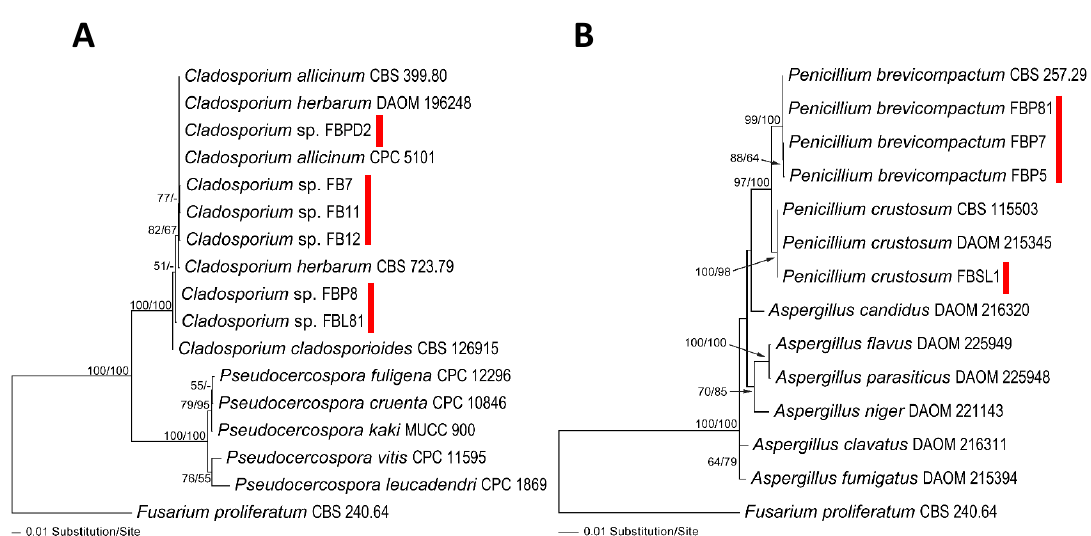
Figure 1. Phylogram of the best ML trees revealed by RAxML from an analysis of the combined ITS–LSU for Cladosporium ( A ) and Penicillium ( B ) strains isolated in this study (lnL = − 3527.0288 and − 4195.2300, respectively). Fusarium proliferatum (CBS 240.64) was considered the outgroup. ML and MP bootstrap supports above 50% were given at the first and second positions, respectively, above or below the branches. Red marks are strains Cladosporium and Penicillium isolated in this study.